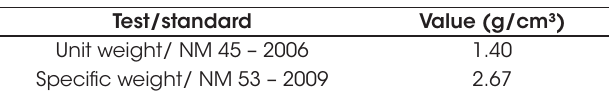
Unit and specific weight of the natural coarse aggregate used